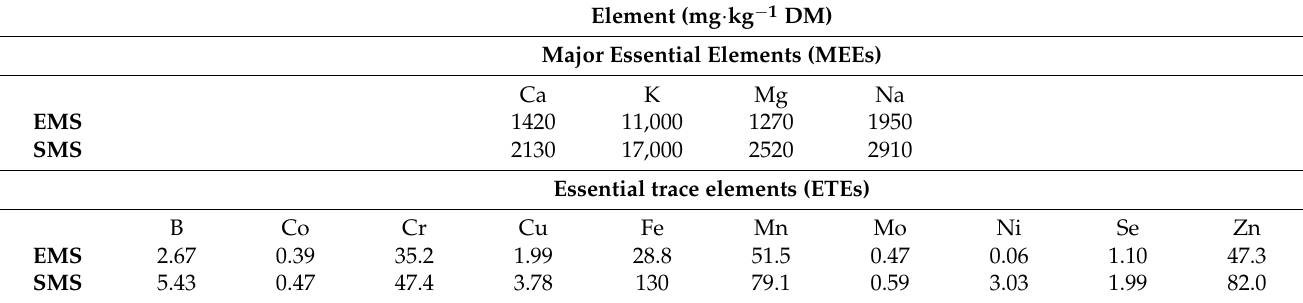
Table 2. Element’s concentration in the substrate (EMS) used for the cultivation of P. djamor and in the substrate after cultivation